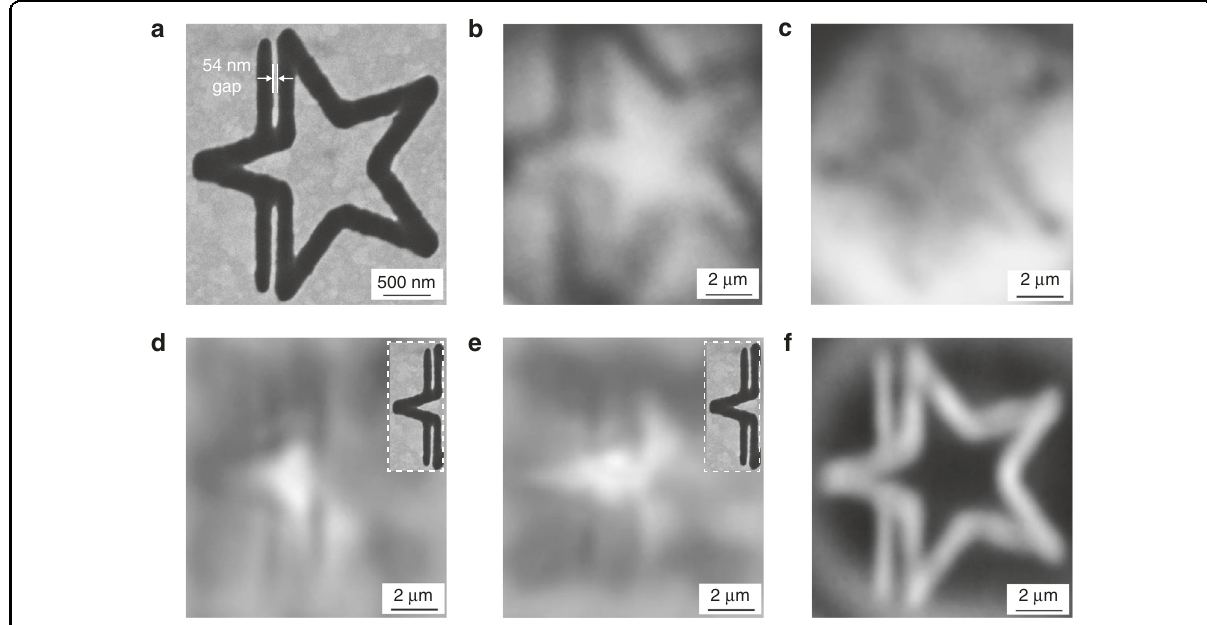
Fig. 3 Imaging comparisons among microspheres and HHMS. Star pattern with a 54 nm gap imaged by a SEM, b a 23 μ m borosilicate glass microsphere ( n ~ 1.52) in air, c a 23 μ m BTG microsphere ( n ~ 2.34) in air, d an 8 μ m BTG microsphere ( n ~ 1.9) immersed in oil ( n ~ 1.34), e an 8 μ m BTG microsphere ( n ~ 2.2) immersed in oil ( n ~ 1.5) and f a BTG HHMS ( n ~2.34) in air. Insets in ( d ) and ( e ): the corresponding SEM images of the region imaged by